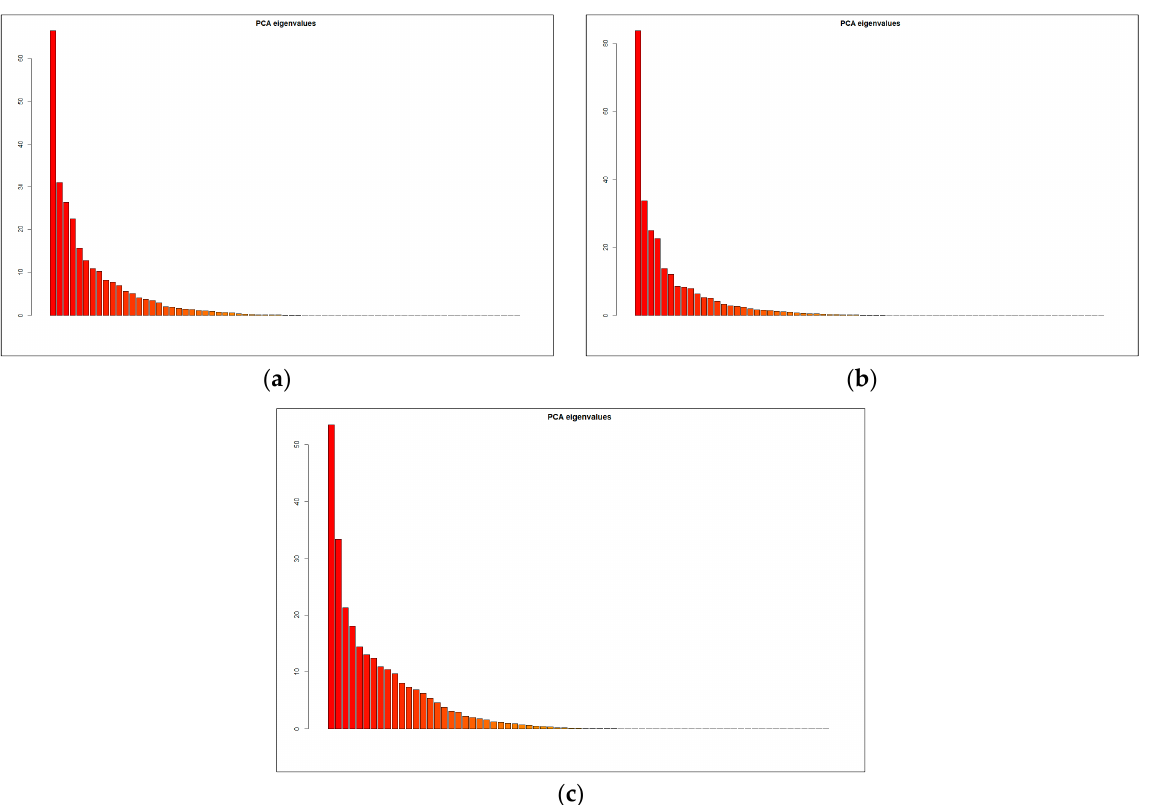
Figure A1. Distribution of eigenvalues based on FPCA: ( a ) period 1; ( b ) period 2; ( c ) period 3.